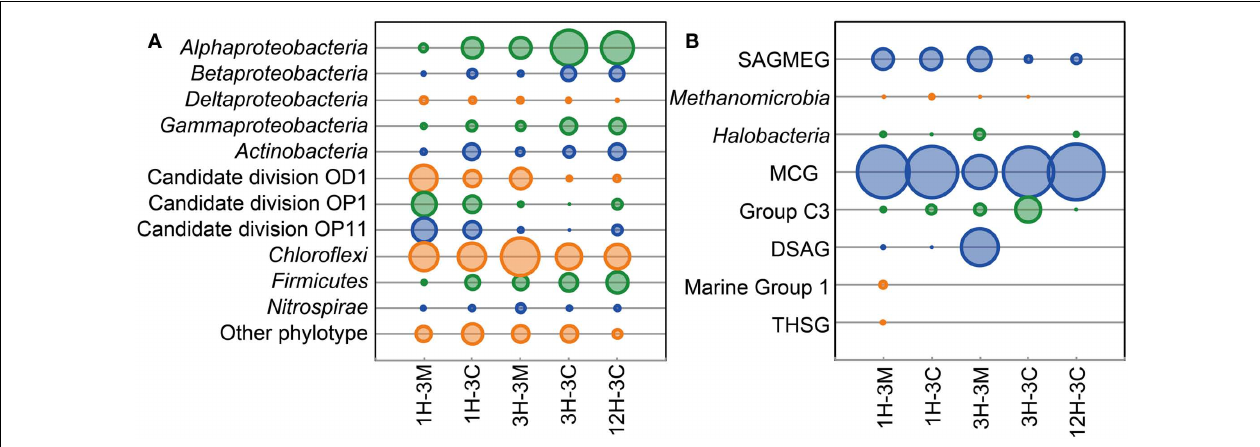
FIGURE 2 | Microbial community compositions in the buried coral fossil carbonates and the clay matrices. Phylogenetic clustering analysis of (A) bacterial and (B) archaeal communities is based on the 16S rRNA gene-tagged sequences.The area of each bubble represents the phylotype frequency in the sample examined.